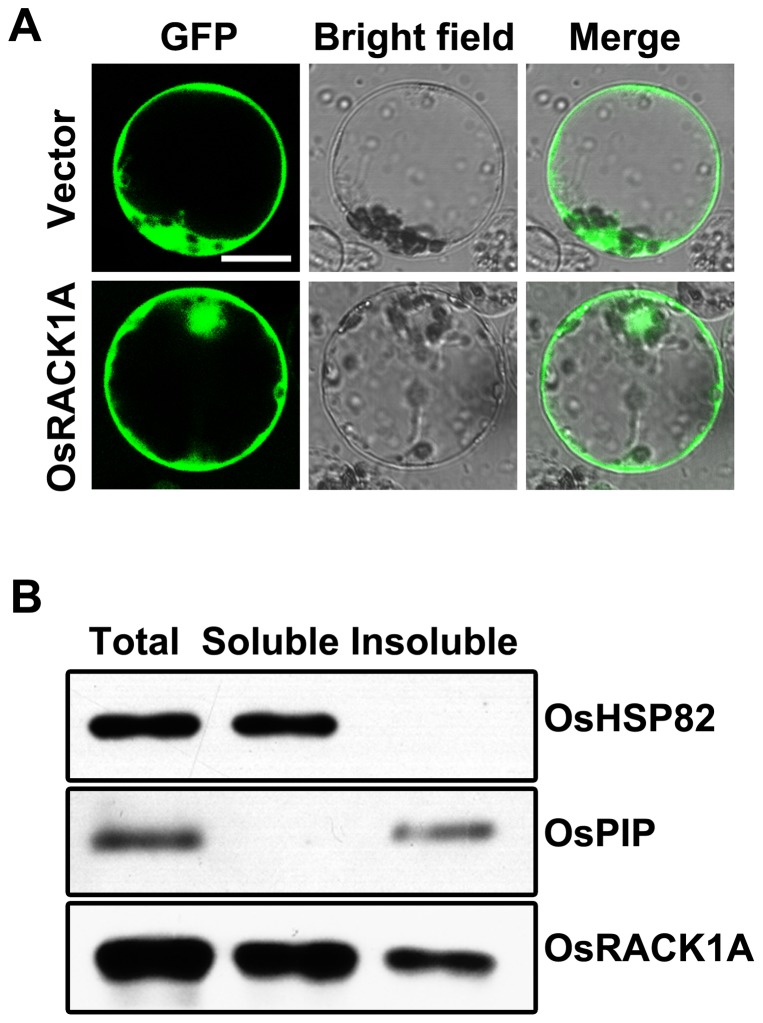
Intracellular localization of OsRACK1A.The intracellular localization of OsRACK1A was monitored with the fluorescence microscopy (A) and using immunoblotting analysis (B). Rice protoplasts were transformed with a vector containing Ubi::OsRACK1A–GFP or Ubi::GFP by PEG method and the florescence signal was observed with an Inverted Microscope (Axio Observer A1, Zeiss) at 16 h after transformation. For immunoblotting assay, the soluble and insoluble fractions of the cells were isolated by differential centrifugation and incubated with polyclonal antibodies against OsRACK1A or OsHSP82 (as reference) or OsPIP (as reference of insoluble protein).